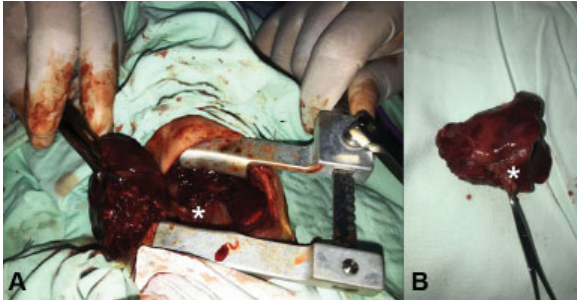
Fig. 3 Surgical fi ndings of bronchopulmonary esophageal fi stula indicated with white